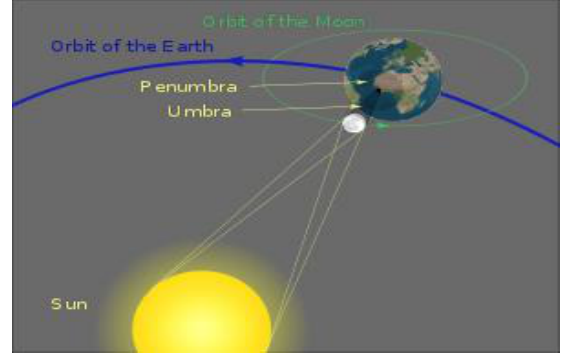
Fig. 1: The Moon shadow cone on the Earth surface and moved